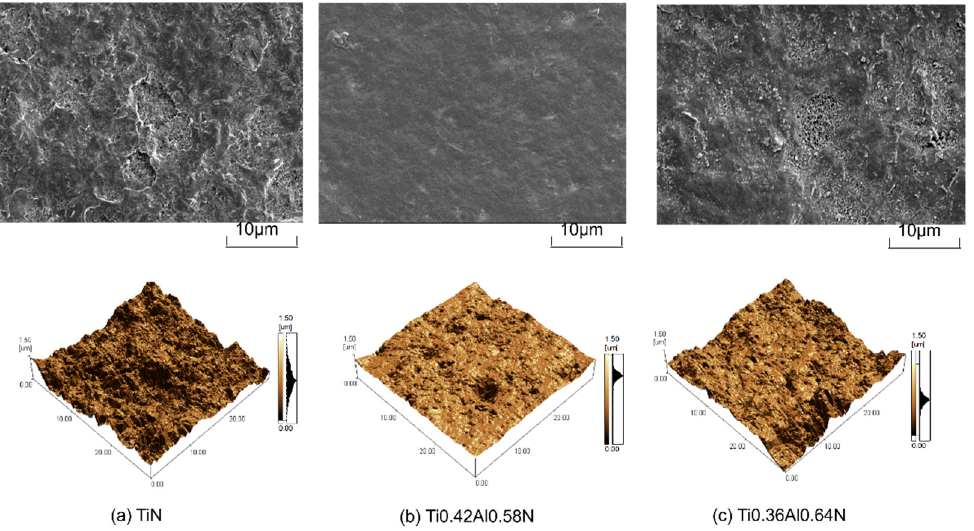
Figure 8. SEM and AFM images of ( a ) TiN, ( b ) Ti0.42Al0.58N and ( c ) Ti0.36Al0.64N. Surface observation was conducted when the erosion depth reached approximately half of the total coating thick- ness.